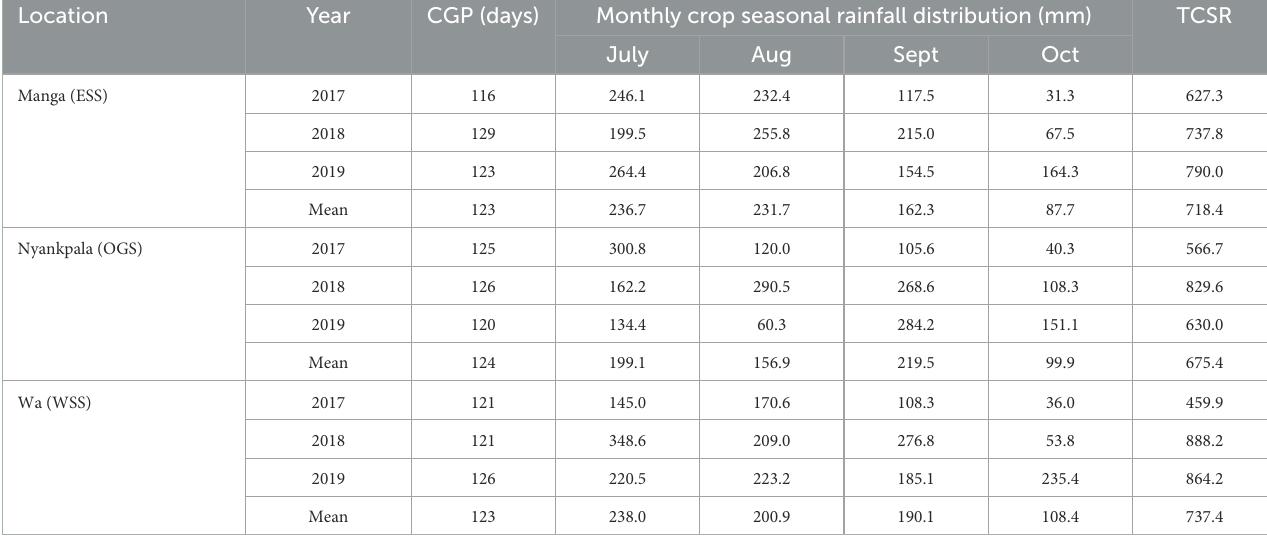
TABLE 2 The CGP, seasonal crop rainfall, and TCSR for Manga, Nyankpala, and Wa (2017–2019).